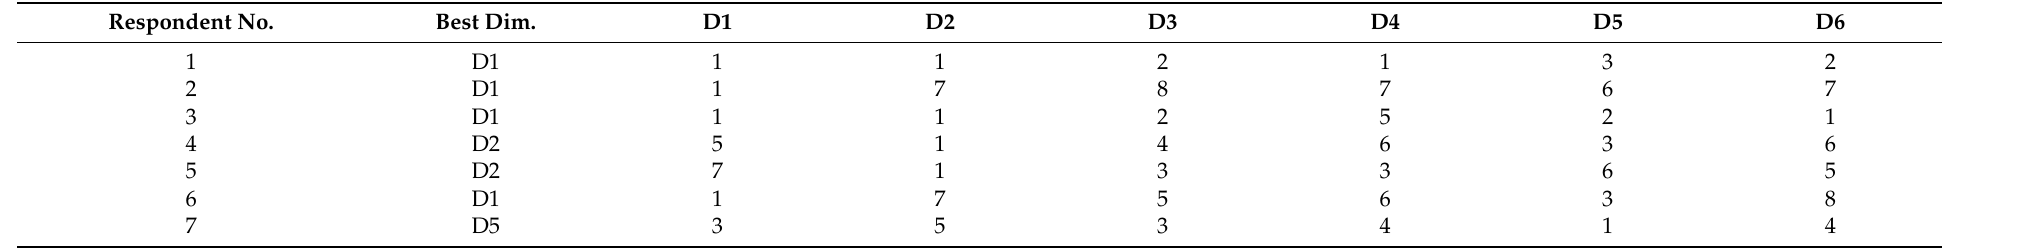
Table 9. BO vectors of dimensions.